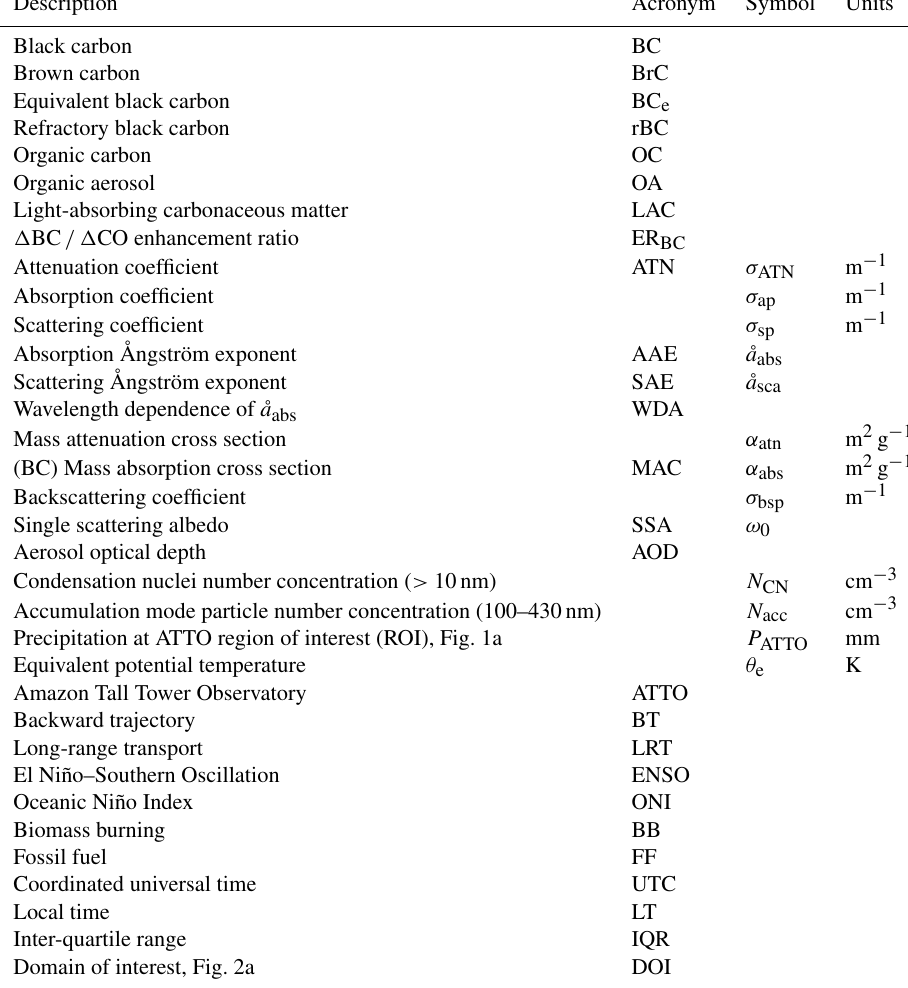
Table A1. List of frequently used symbols and